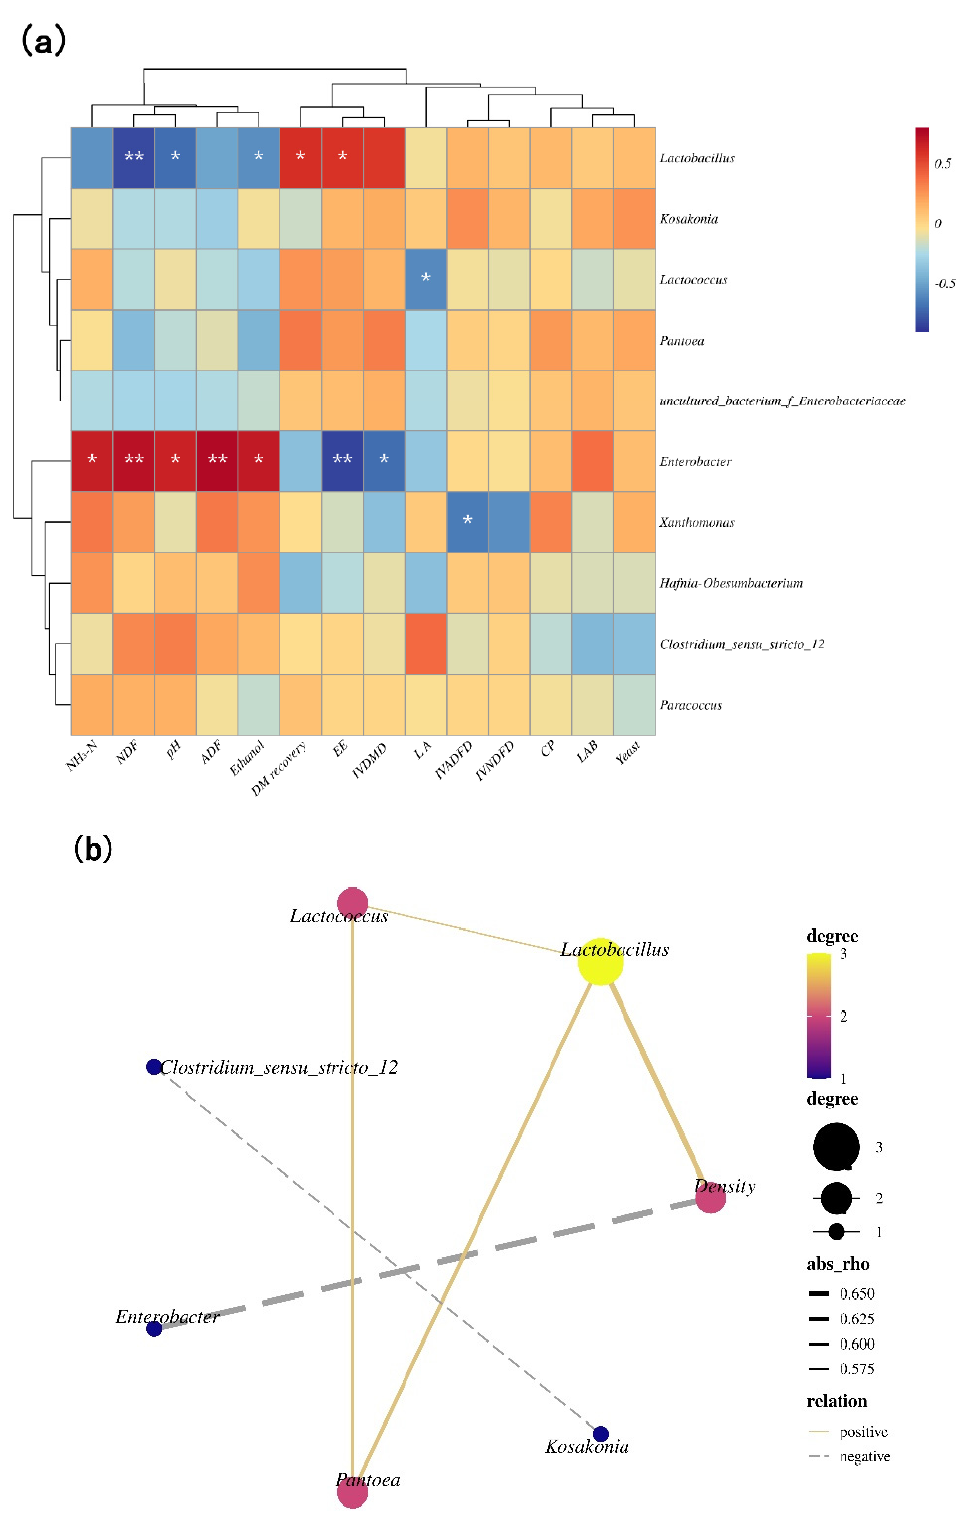
Figure 3. ( a ) Correlation clustering and heat map analysis of top 10 genera with pH, LA, ethanol, NH 3 -N, LAB, yeast, CP, NDF, ADF, EE, DM recovery, IVDMD, IVNDFD, and IVADFD; ( b ) correlation network among main bacterial genera (top 10) and density ( b ) ( n = 12). The values presented by colors in the heat map correspond to the Pearson correlation coefficient r, which ranged between − 0.5 and 0.5, where r < 0 indicates a negative correlation (blue), r > 0 indicates a positive correlation (red), ‘*’ represents p < 0.05, and ‘**’ represents p < 0.01. In ( b ), absolute value of correlation coefficient > 0.5 and p -value <